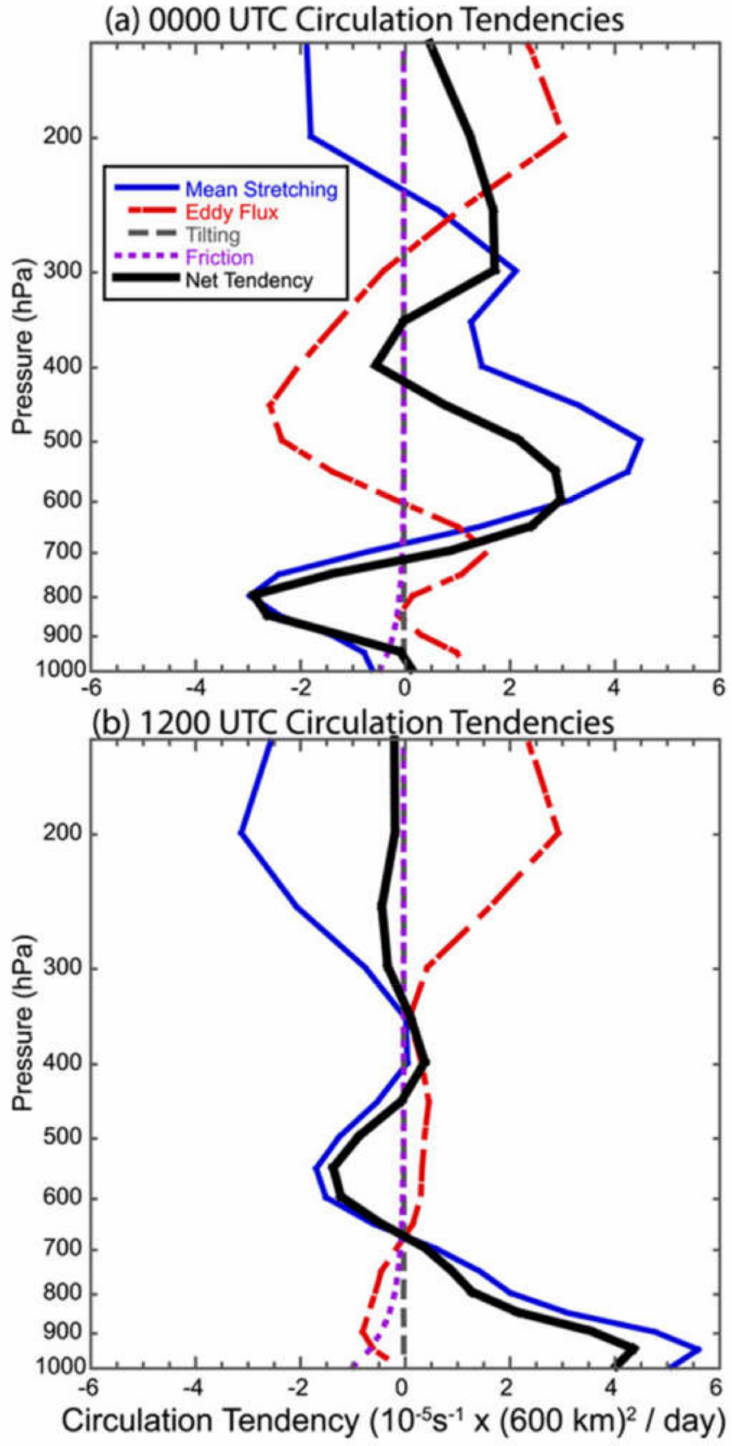
Figure 17. Meso- α -scale (600 km × 600 km) circulation tendencies with height at ( a ) 0000 and ( b ) 1200 UTC 13 Sep. Budget terms are mean stretching tendency (solid blue), eddy flux tendency (dash-dotted red), tilting tendency (long-dashed gray), friction tendency (short-dashed purple), and net tendency calculated by summation of thecomponent tendencies (thick solid black). Adapted from